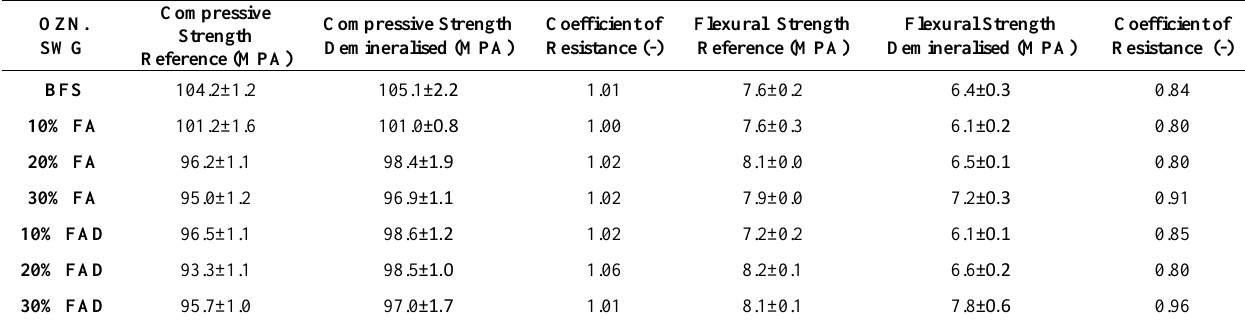
Table 6. Influence of leaching in demineralized water.